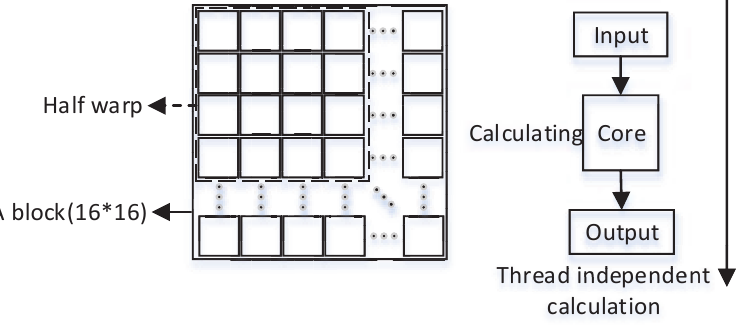
Figure 3. Thread allocation